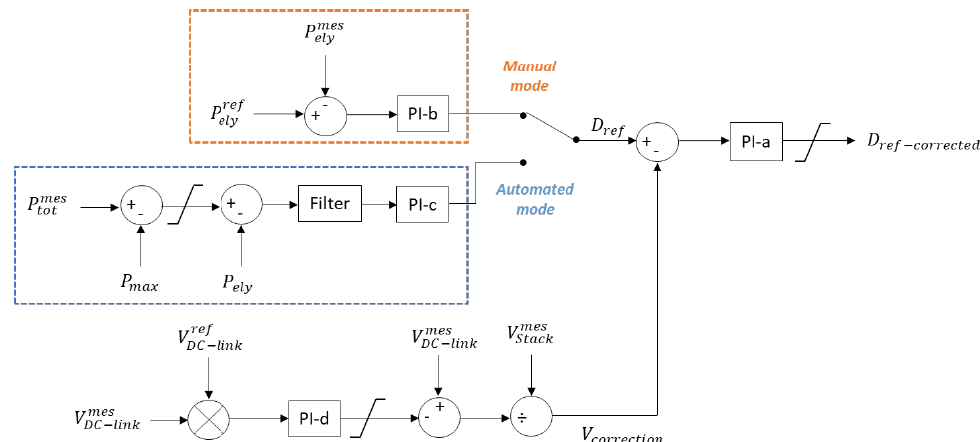
Figure 13. Buck converter controller in Scenario